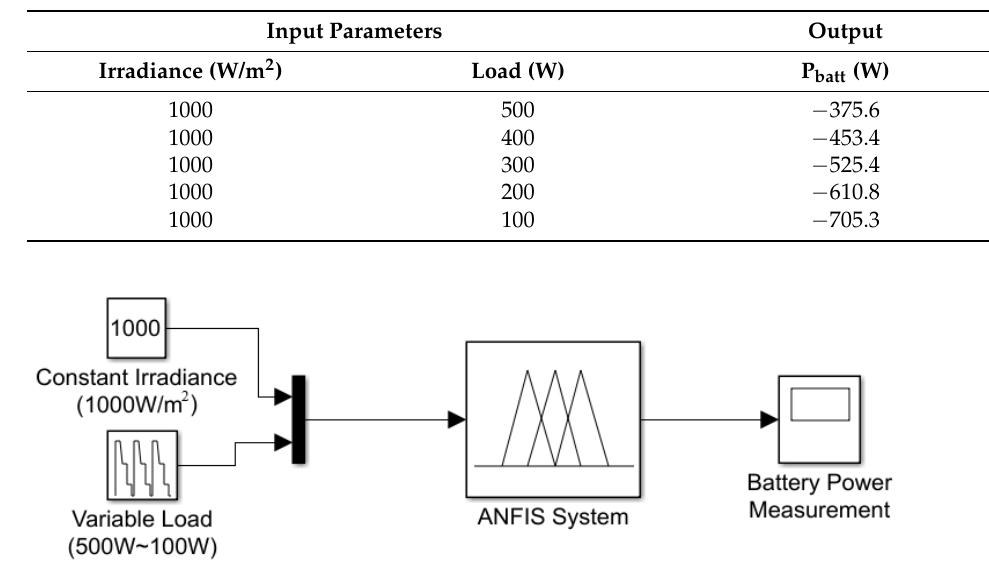
Figure 7. P batt ANFIS model.